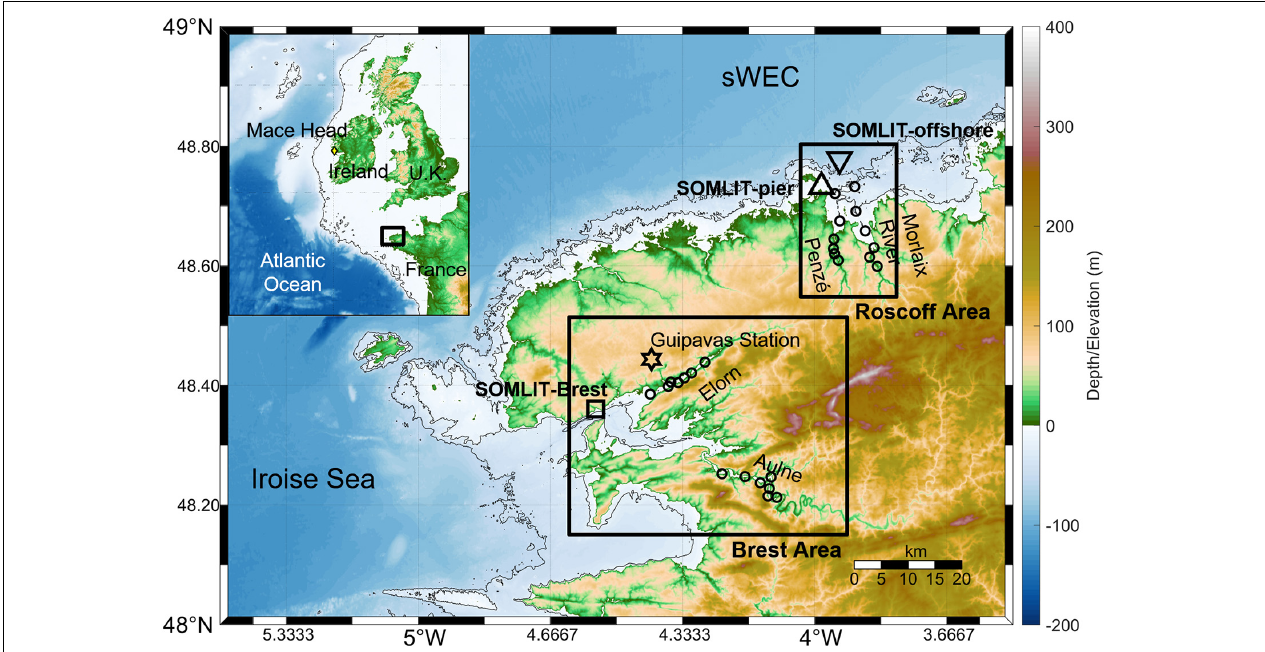
FIGURE 1 | Map, bathymetry, and topography of the study area in the southern Western English Channel (sWEC), with the two regions of study: the Brest region, with the SOMLIT-Brest station (black square), the Aulne and Elorn rivers; and the Roscoff region, with SOMLIT-pier (upward black triangle) and SOMLIT-offshore (downward black triangle) stations and the Penzé and Morlaix rivers. Black circles indicate the locations of sampling in the rivers and the black star the location of the Meteo France station (“Guipavas station”) for wind speed data. Bathymetry contours show 20 and 50-m isobaths. (Top left) Map and bathymetry (200-m isobath) of the North Atlantic Ocean with the location of the Mace Head atmospheric station (yellow diamond); the black frame represents the zoom on the study area. Note that the color map (–6000 to 2000 m) is different from the main